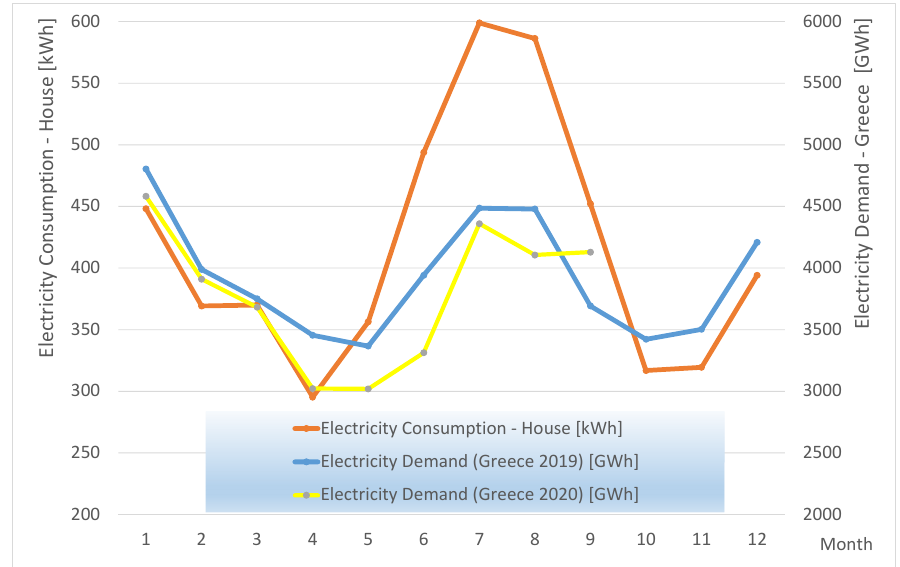
Figure 8. Monthly variation of electricity consumption of the specific house, compared to the monthly electricity consump- tion of Greece during 2019 and 2020 (first 9 months).